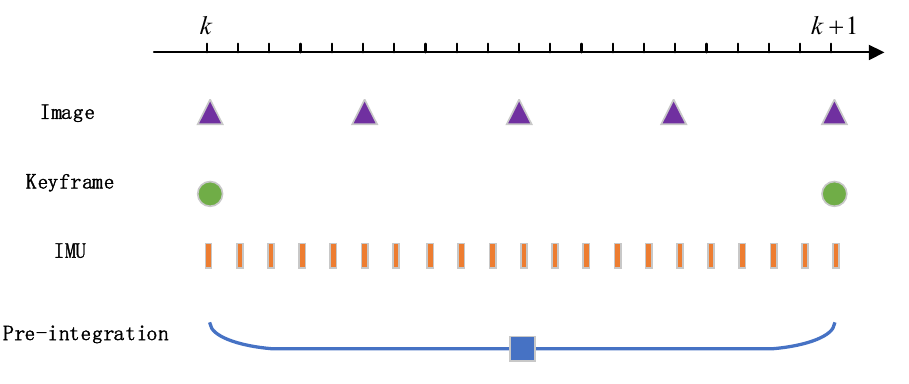
Figure 2. IMU pre ‐ integration.